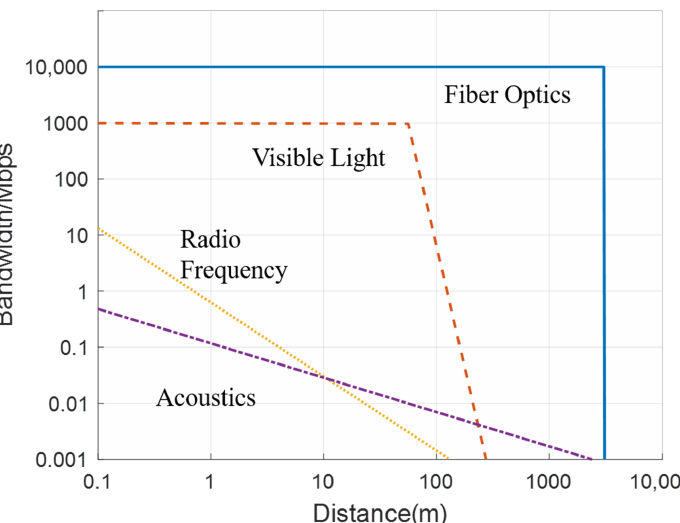
Figure 9. Comparison of the different underwater communication channels currently available